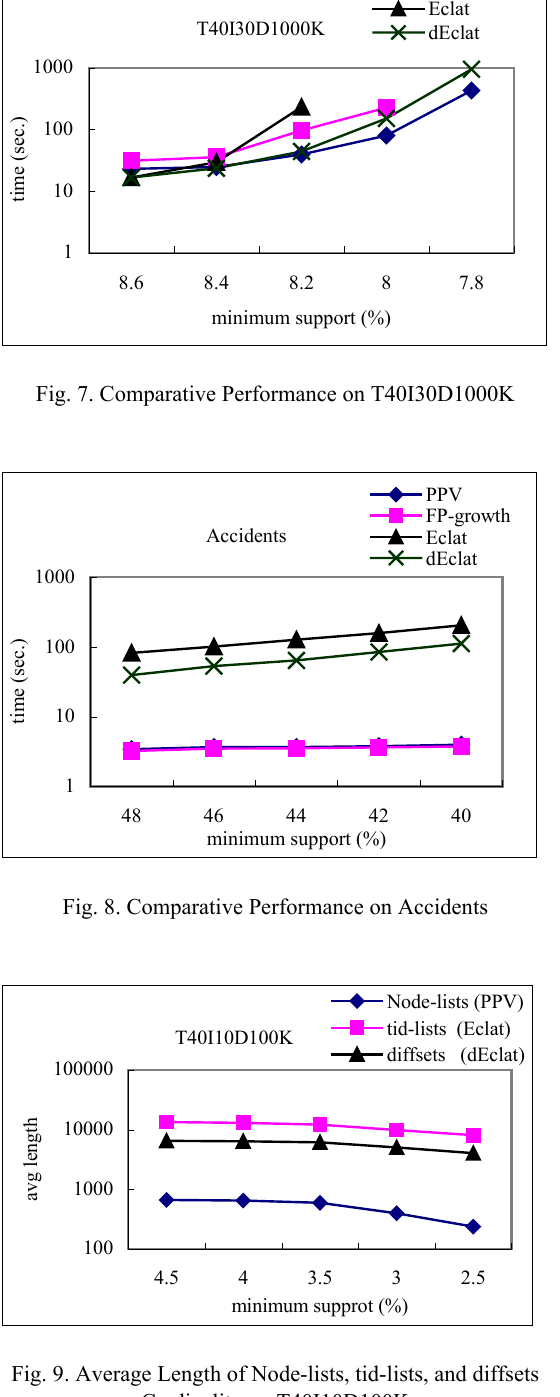
Fig. 9. Average Length of Node-lists, tid-lists, and diffsets Cardinality on T40I10D100K